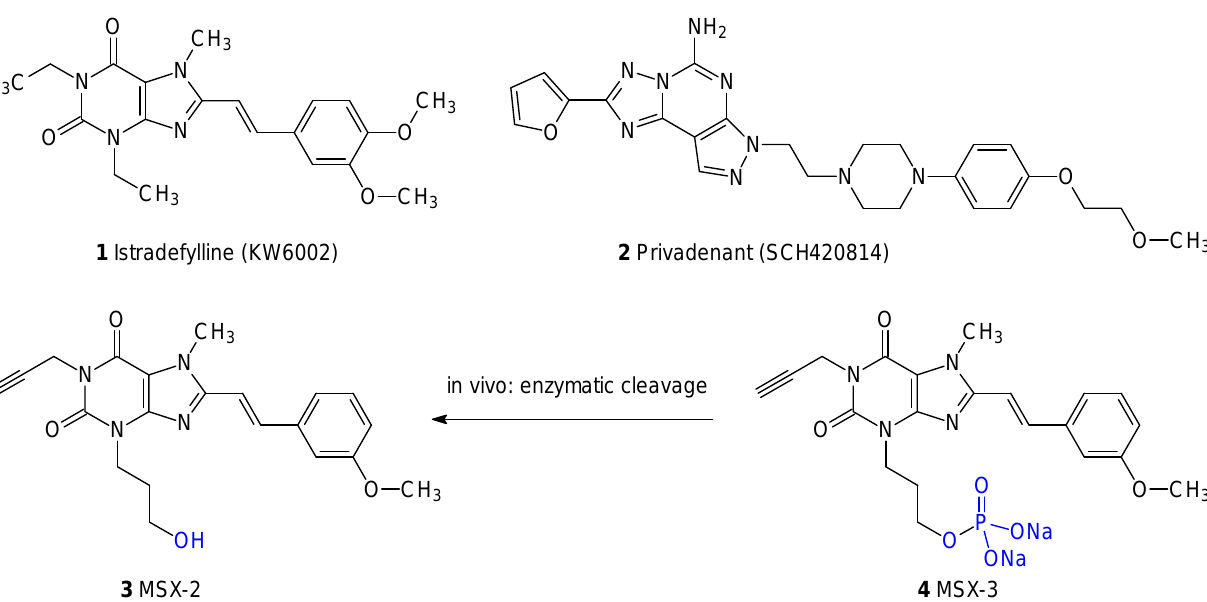
Figure 1. Structures of selected adenosine A